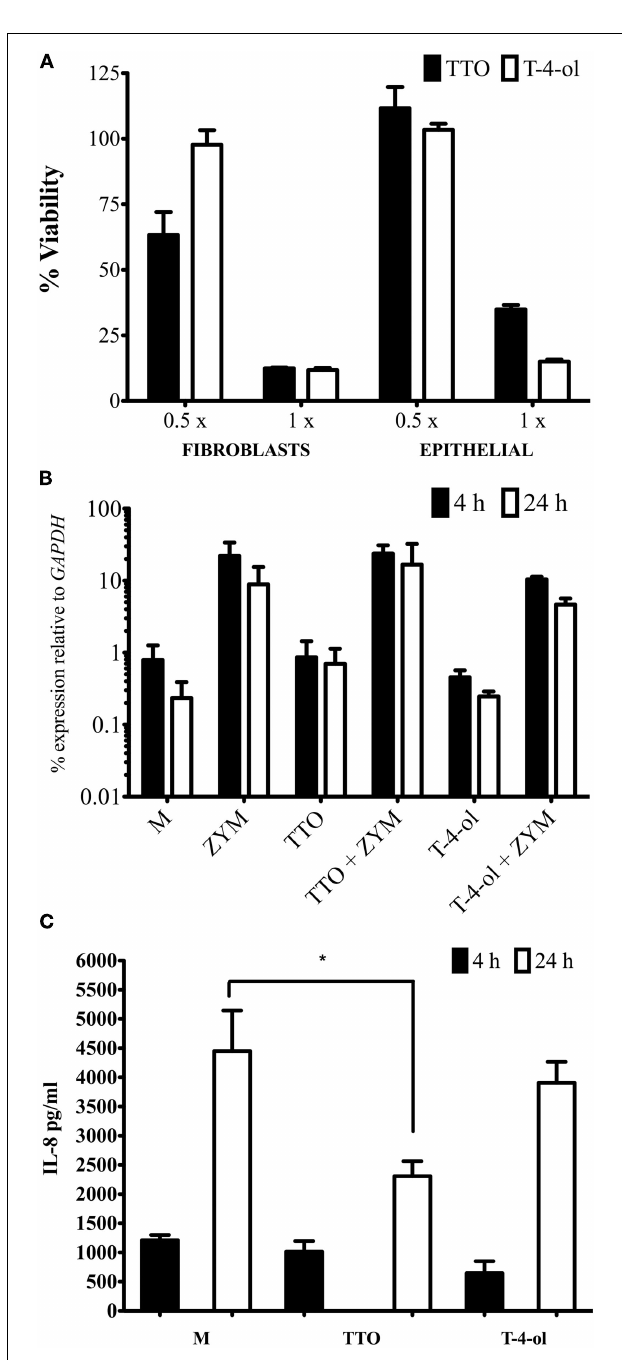
FIGURE 4 |Tea tree oil andT-4-ol are biologically active against mammalian cells. (A) PR fibroblast and OKF6 epithelial cells were grown until 90–100% confluent.These were exposed to 0.5 and 1 × MIC 50 of each compound for 2min. Cell viability was assessed using an XTT assay after incubation in 5% CO 2 at 37˚C for 2h.Viability was calculated based on unexposed control cells. For cytokine studies OKF6 cells were grown in 12 well tissue culture trays treated withTTO andT-4-ol at 0.5 × MIC 50 for 2min, washed then stimulated with zymosan (50 µ g/ml). Cells were processed for (B) qPCR analysis and (C) supernatant was processed for protein analysis of IL-8. Each assay was performed on three independent occasions in triplicate. * p < 0.05. Error bars represent the ± standard error of the